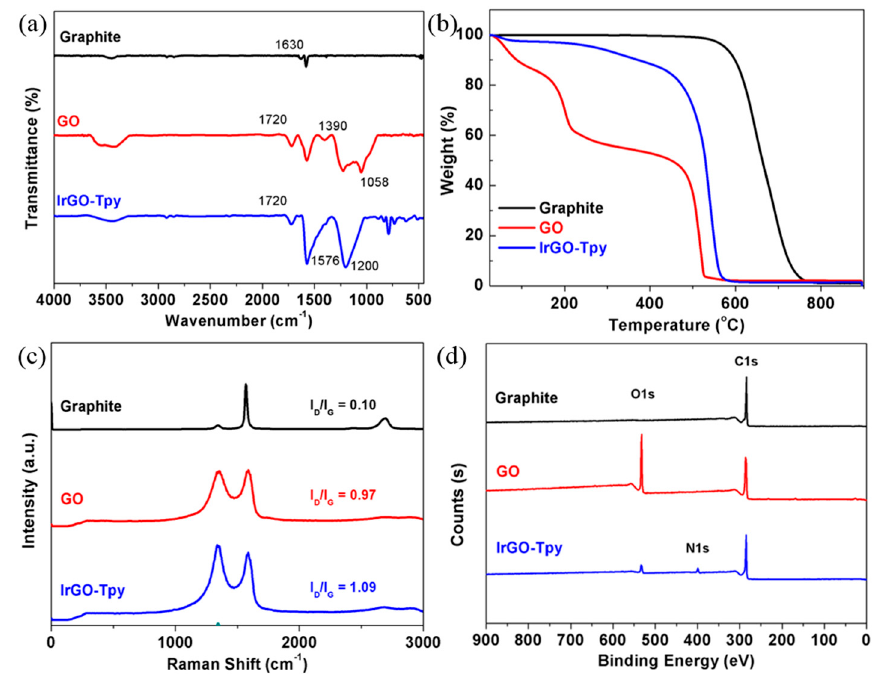
Figure 2. ( a ) FT ‐ IR spectra, ( b ) TGA thermograms in air, ( c ) Raman spectra with I D /I G ratios, ( d ) XPS survey spectra of graphite, graphene oxide (GO), and IrGO ‐ Tpy.